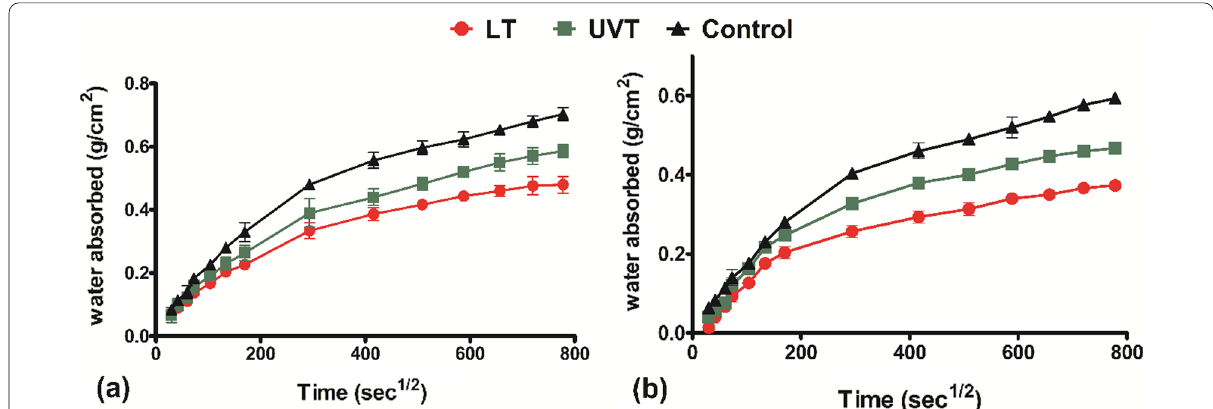
Fig. 6 Water absorption of mortar specimens treated with live (LT) and UV treated (UVT) Synechocystis pevalekii at a 7-day, and b 28-day of